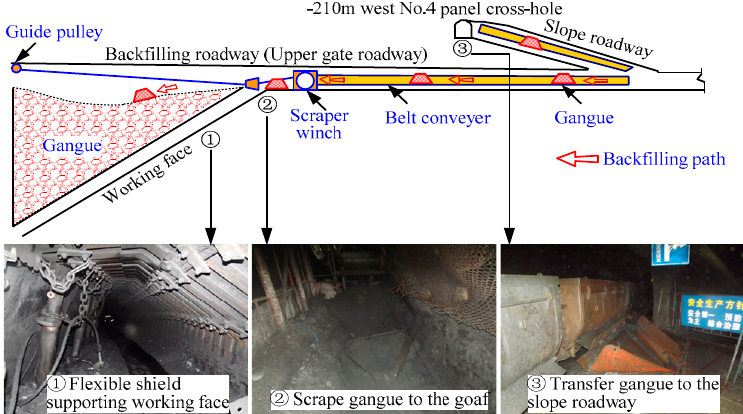
Figure 2. Backfilling process and system layout of the 845 working face.